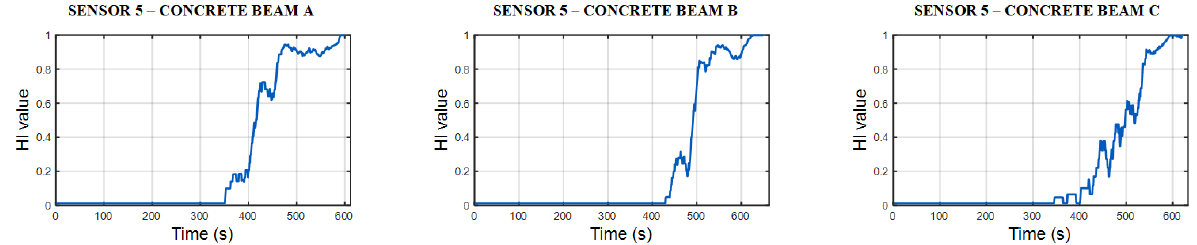
Figure 11. HIs of test datasets constructed by the proposed model for concrete beam A, B, and C.